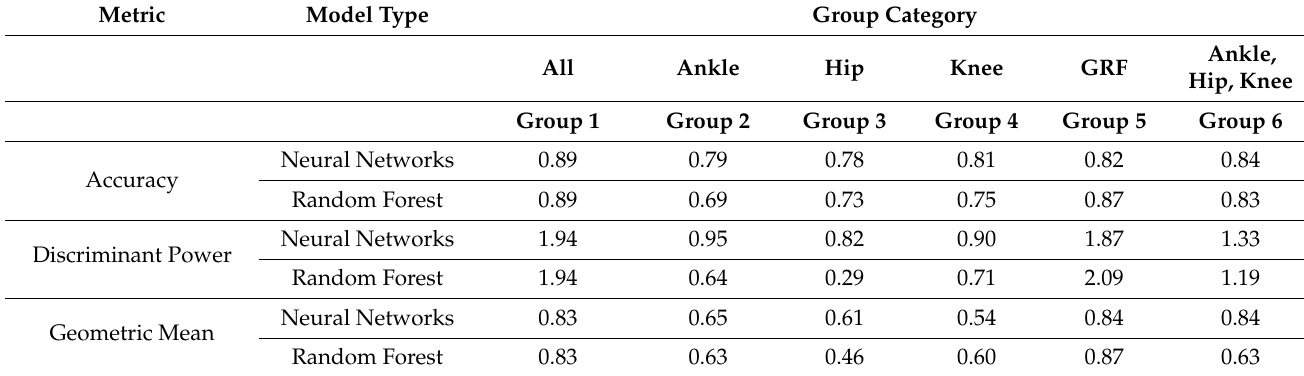
using all gait features. Table 2. A summary of the models’ performances on the testing data. It evaluates the applied model scores utilizing every group based on four performance metrics. The shaded columns highlight the comparison between all gait features models (Group 1) and GRF features (Group 6).